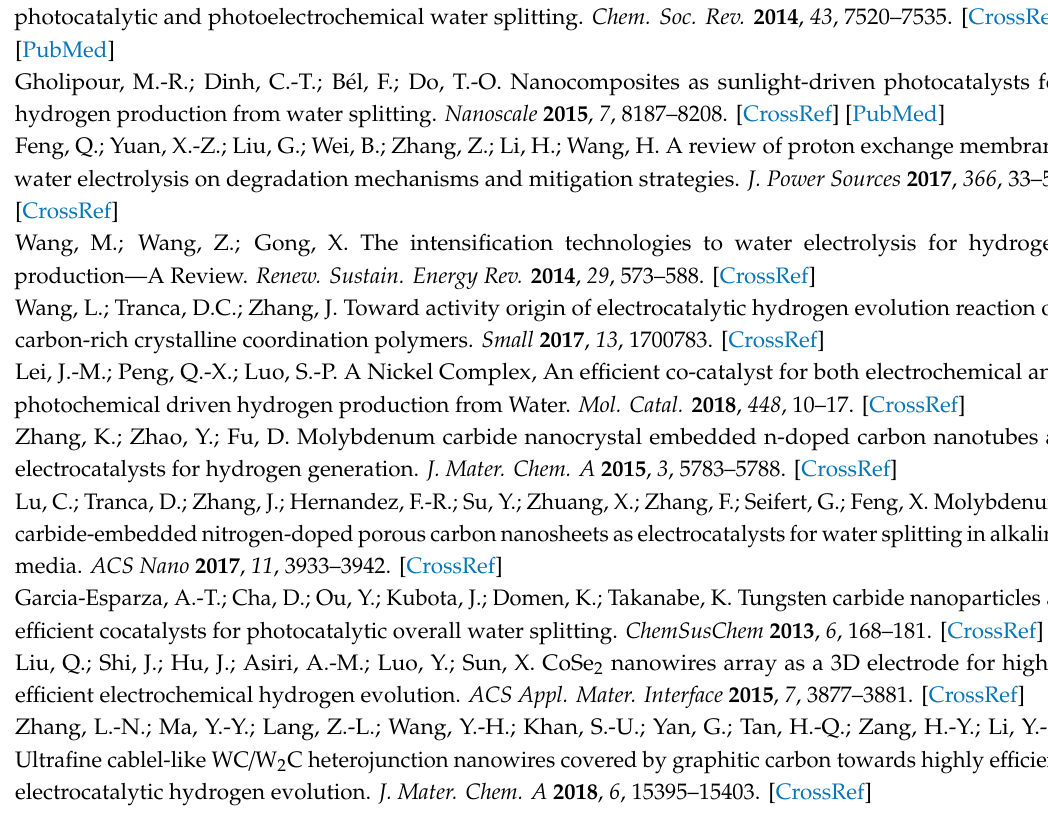
Figure S1: The whole reaction process. Equation S1: The related equations for the further molten salt reactions for the carburization of AMT into WC. Figure S2: The schematic illustration, regarding the HER activities of the catalysts (a) in acidic media and (b) alkaline media. Figure S3: The size and its distribution values of the nanoparticles. Figure S4: SEM images of (a) 3 AMT and (b) 5 AMT. Figure S5: EDX images of XAMT. Figure S6: SEM images of (a) 4 AMT at 800 ◦ C and (b) 4 AMT at 1000 ◦ C. Figure S7: The full XPS spectra of 4 AMT. Figure S8: (a) The full XPS spectra of WC / C (without N–S), (b) W 4f, and (c) C 1s. Figure S9: N 2 adsorption–desorption isotherm curves of (a) 4 AMT and (b) without N–S-doped WC / C. Figure S10: CV curves of (a) 3 AMT, (b) 4 AMT (c) 5 AMT, and (d) WC / C at di ff erent scanning rates, over potential range of 0.1–0.3 V vs. RHE in 0.5 M H 2 SO 4 . Table S1: Comparison of 4 AMT with other WC catalyst in 0.5 M H 2 SO 4